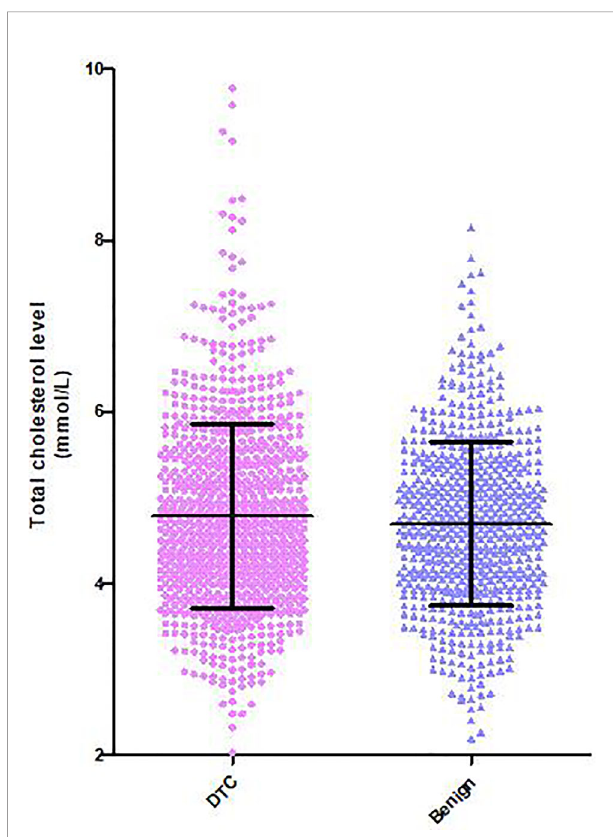
FIGURE 1 | Distribution of serum total cholesterol levels in patients with DTC and benign thyroid nodules. Serum total cholesterol in the DTC group was signi fi cantly higher than that in patients without thyroid